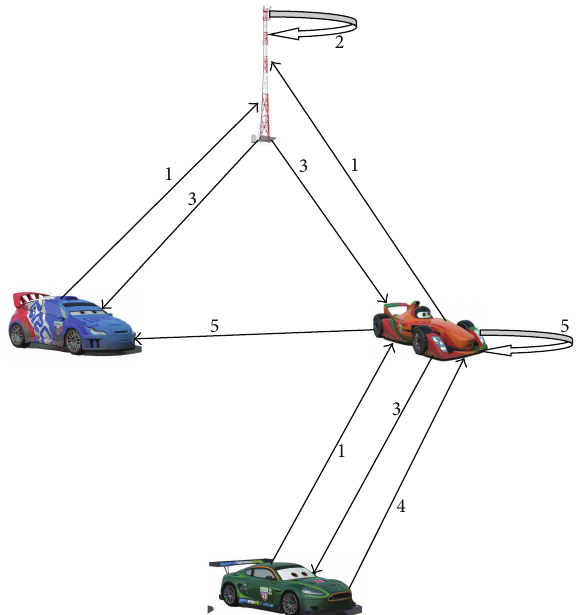
Figure 1: Media mixing